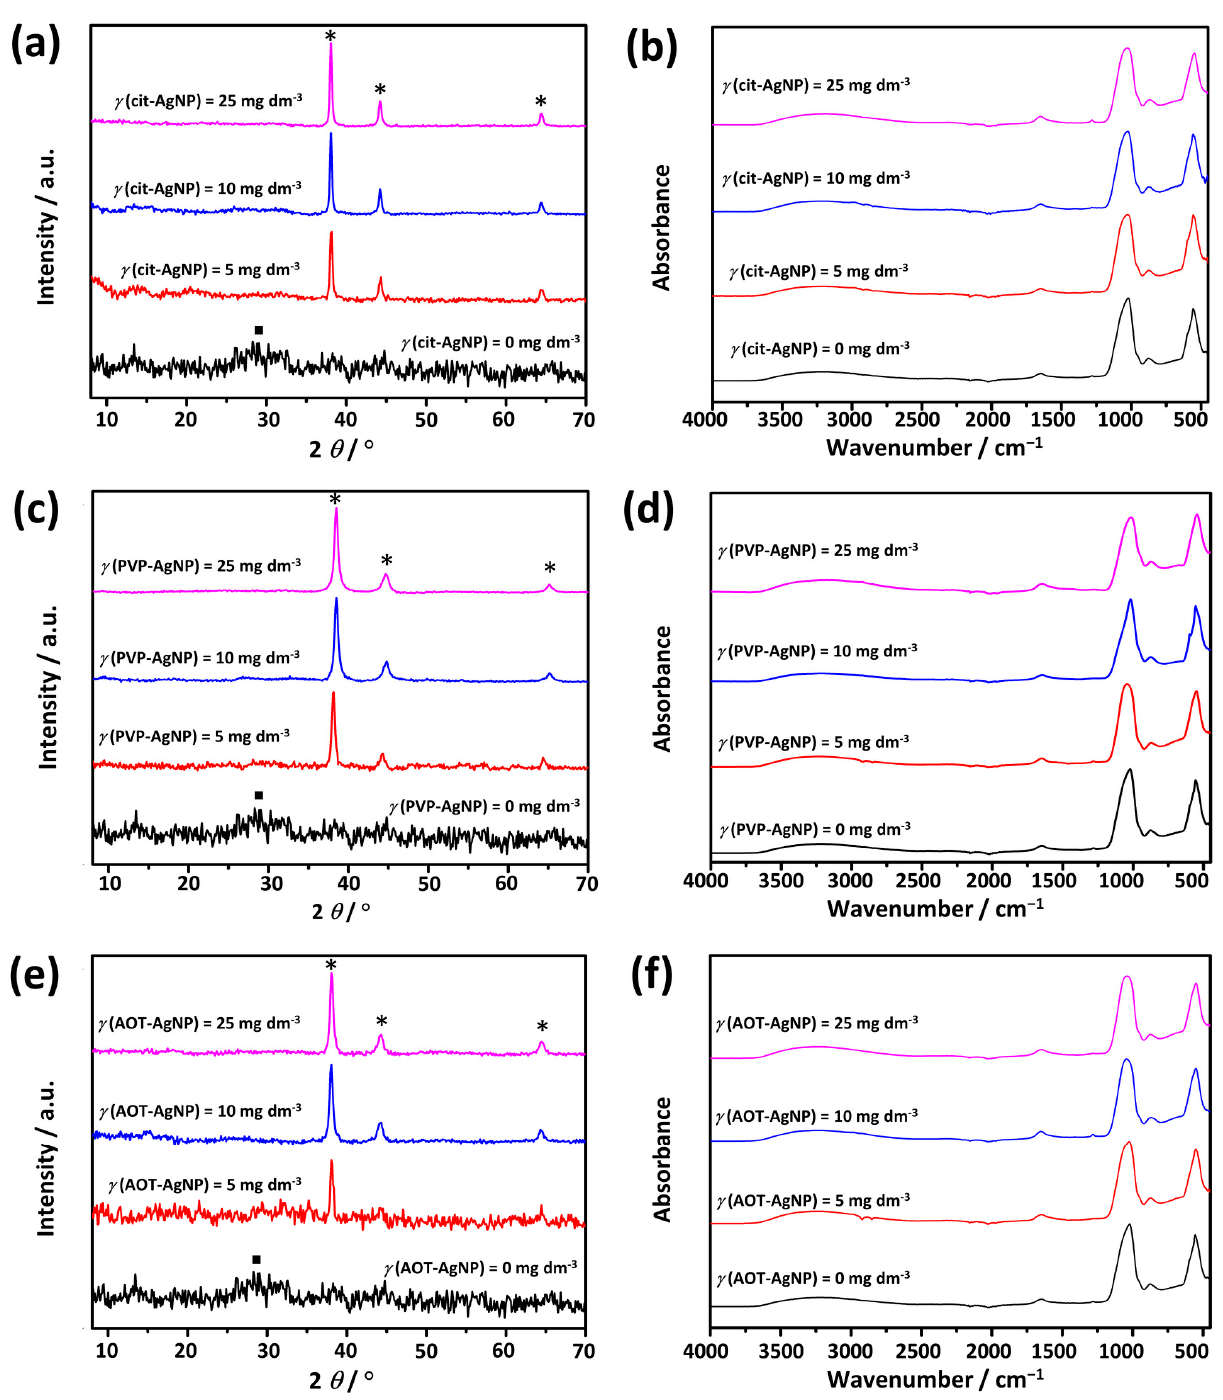
Figure 5. PXRD patterns ( a , c , e ) and FTIR spectra ( b , d , f ) of precipitates obtained after 10 min reaction time in the control system and in the presence of silver nanoparticles (AgNPs) stabilized with ( a , b ) citrate (cit-AgNPs), ( c , d ) poly(vinylpyrrolidone) (PVP-AgNPs), and ( e , f ) sodium bis(2-ethylhexyl) sulfosuccinate (AOT-AgNPs). c (CaCl 2 ) = c (Na 2 HPO 4 ) = 4 · 10 ‒ 3 mol dm ‒ 3 , pH 7.4, 25 °C. ■ — amorphous calcium phosphate, *—silver nanoparticles.